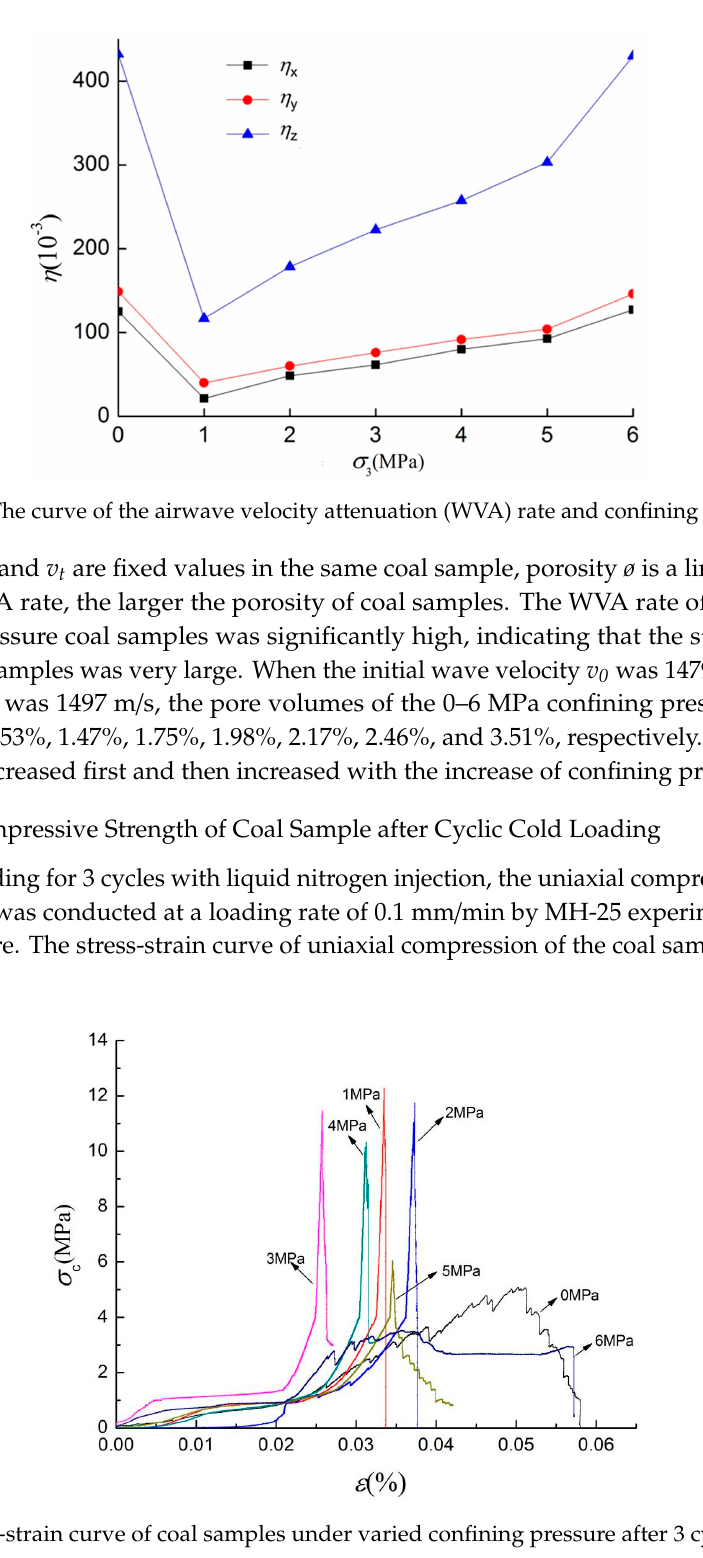
Figure 7. Compressive strength vs. confining pressure of coal samples under varied confining pressures after 3 cycles of liquid nitrogen injection. 0